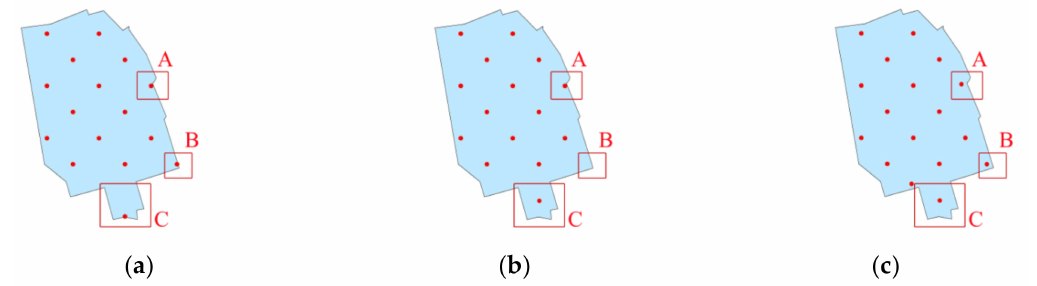
Figure 14. Regular area 3. ( a ) Filling using the traditional three-square type method. ( b ) The effect of